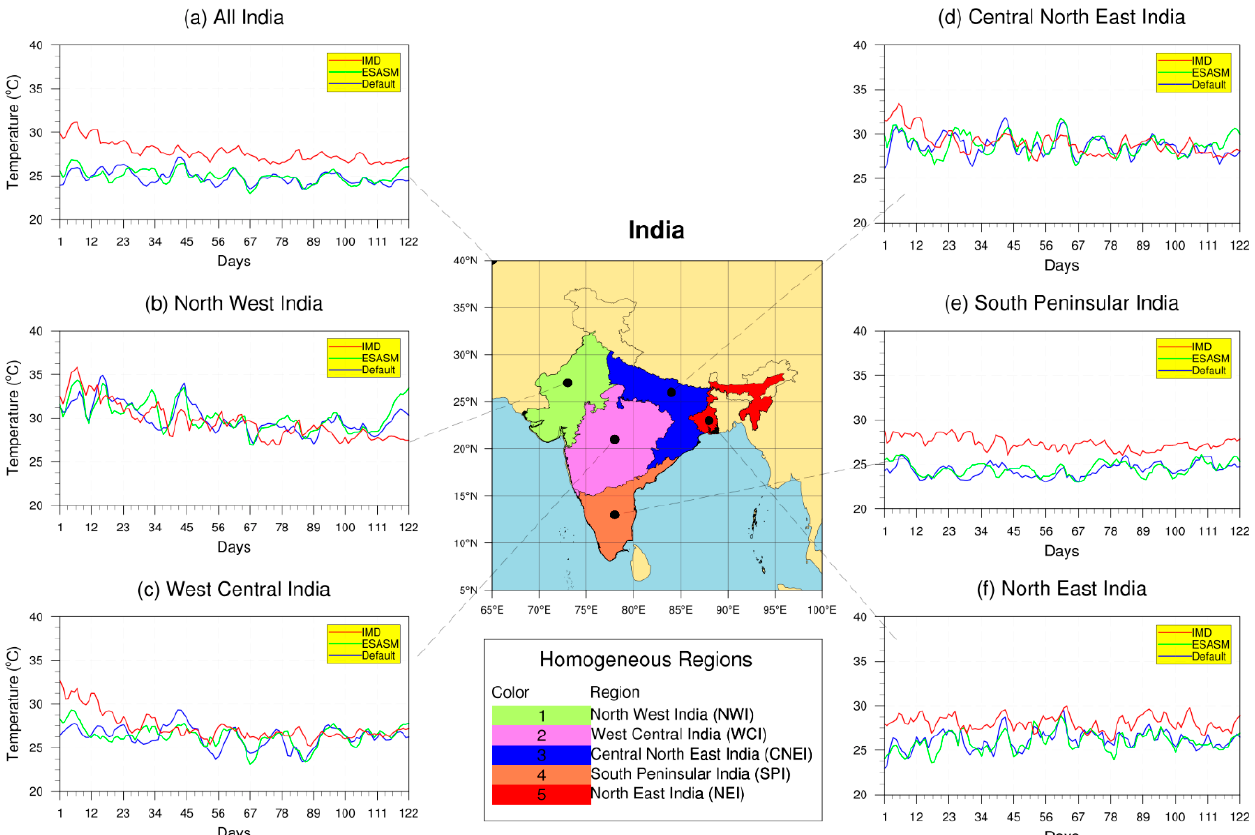
Figure 5. Same as Figure 4, but for the year 2011. Table 2. Temporal statistics of surface temperature (°C) from default, ESA configuration and IMD data over the whole of India and five homogeneous regions for the years 2002 and 2011. *: signi fi cant at 95% and †: not signi fi cant at 95%.